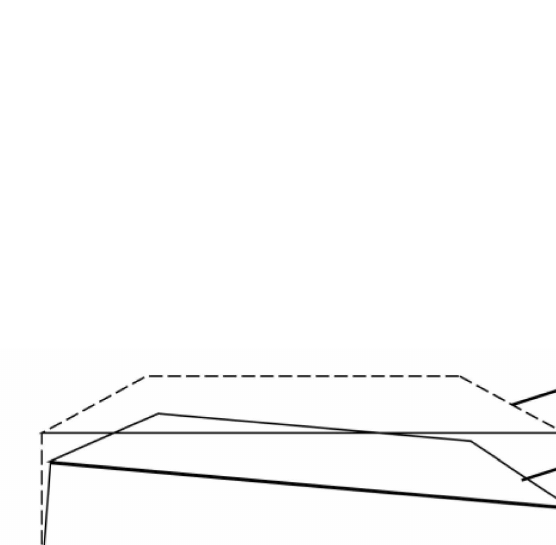
Fig. 1. Illustration of Problem Statement